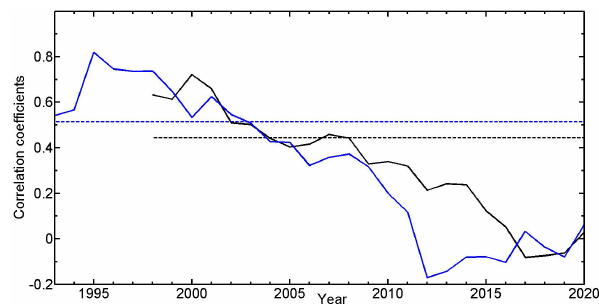
Figure 2. Moving correlations of the detrended and ENSO-signal- removed SIOD and SAOD indices using a 20-year (solid black line) and a 15-year (solid blue line) sliding window. Dashed lines de- note the correlation coefficients with the 95% confidence level for 20 (black) and 15 (blue) samples. The abscissa indicates the end year of the moving correlations. The above results were obtained using the Kaplan Extended SST V2